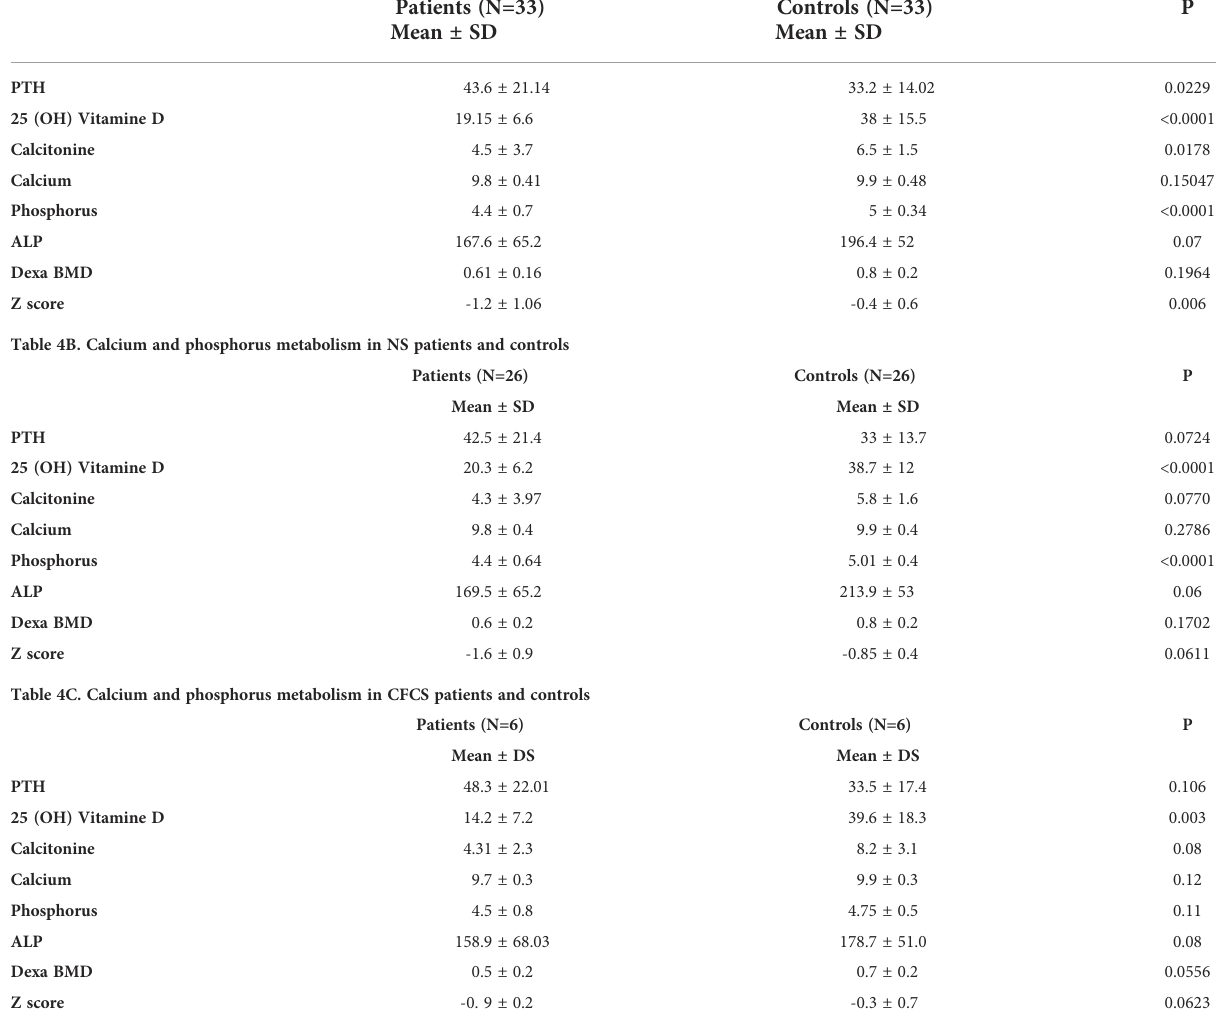
TABLE 4A Calcium and phosphorus metabolism in all patients and controls.